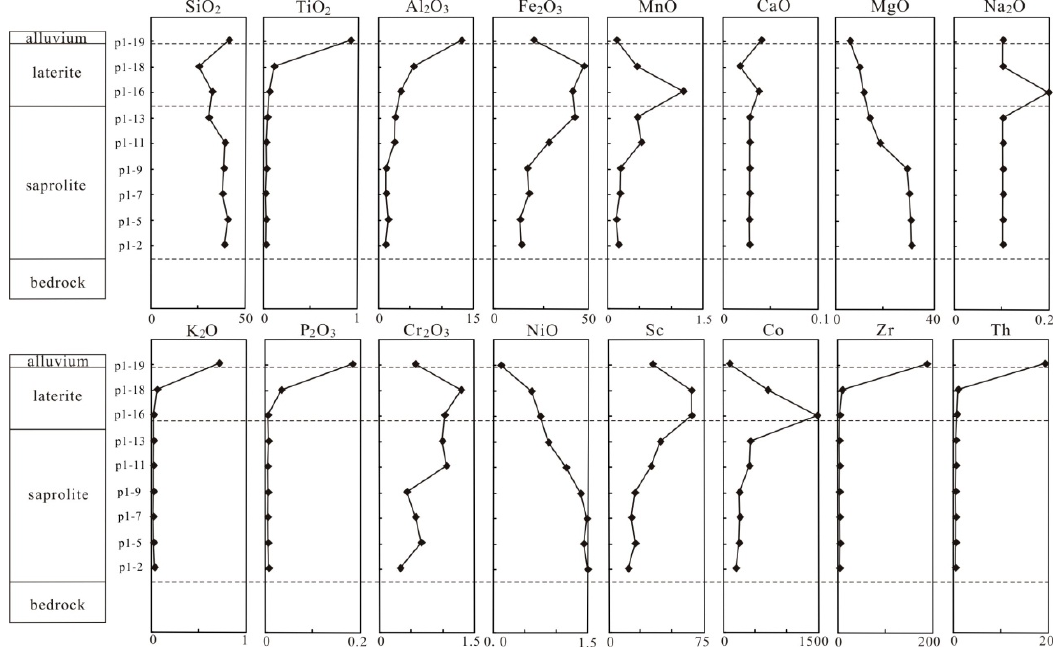
Figure 7. Variations of the major elements and selected trace elements with depth through the laterite profile with depth.